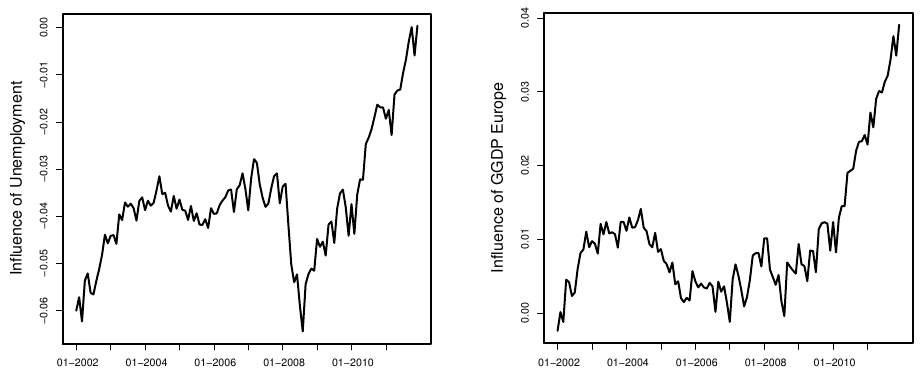
Figure 16. Sensitivity of the logarithmized ARR on Unemployment ( left ) and GGDP Europe ( right ).